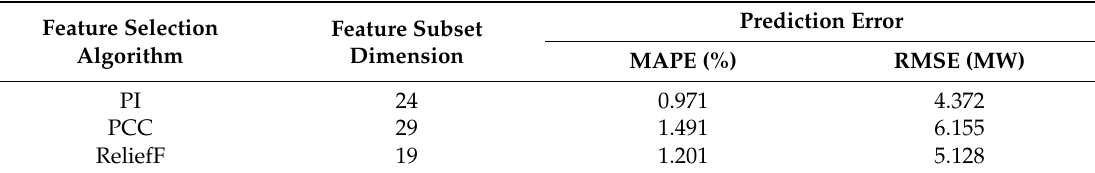
Table 6. Comparison of three feature selection algorithms when 1-h-ahead prediction is conducted.